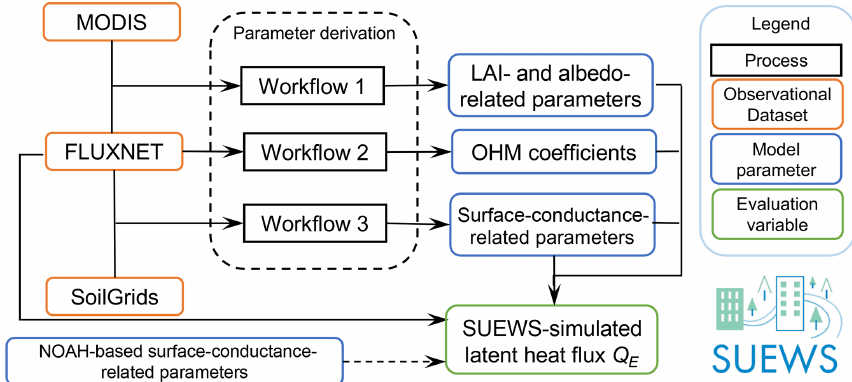
Figure 1. Overview of workflows to derive parameters and to undertake and to evaluate simulations. Acronyms are defined in Sects. 2 and 3. More details are provided in Figs. 3, 5 and